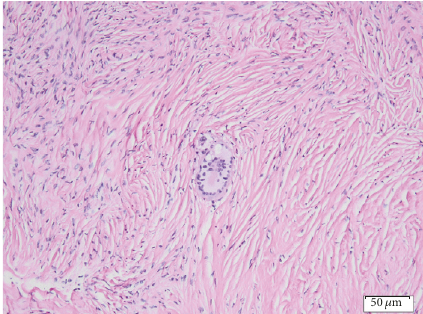
Figure 3: The single, Langhans-type multinucleated giant cell within the fibrotic focus of the left ovary (Hematoxylin and Eosin, ×